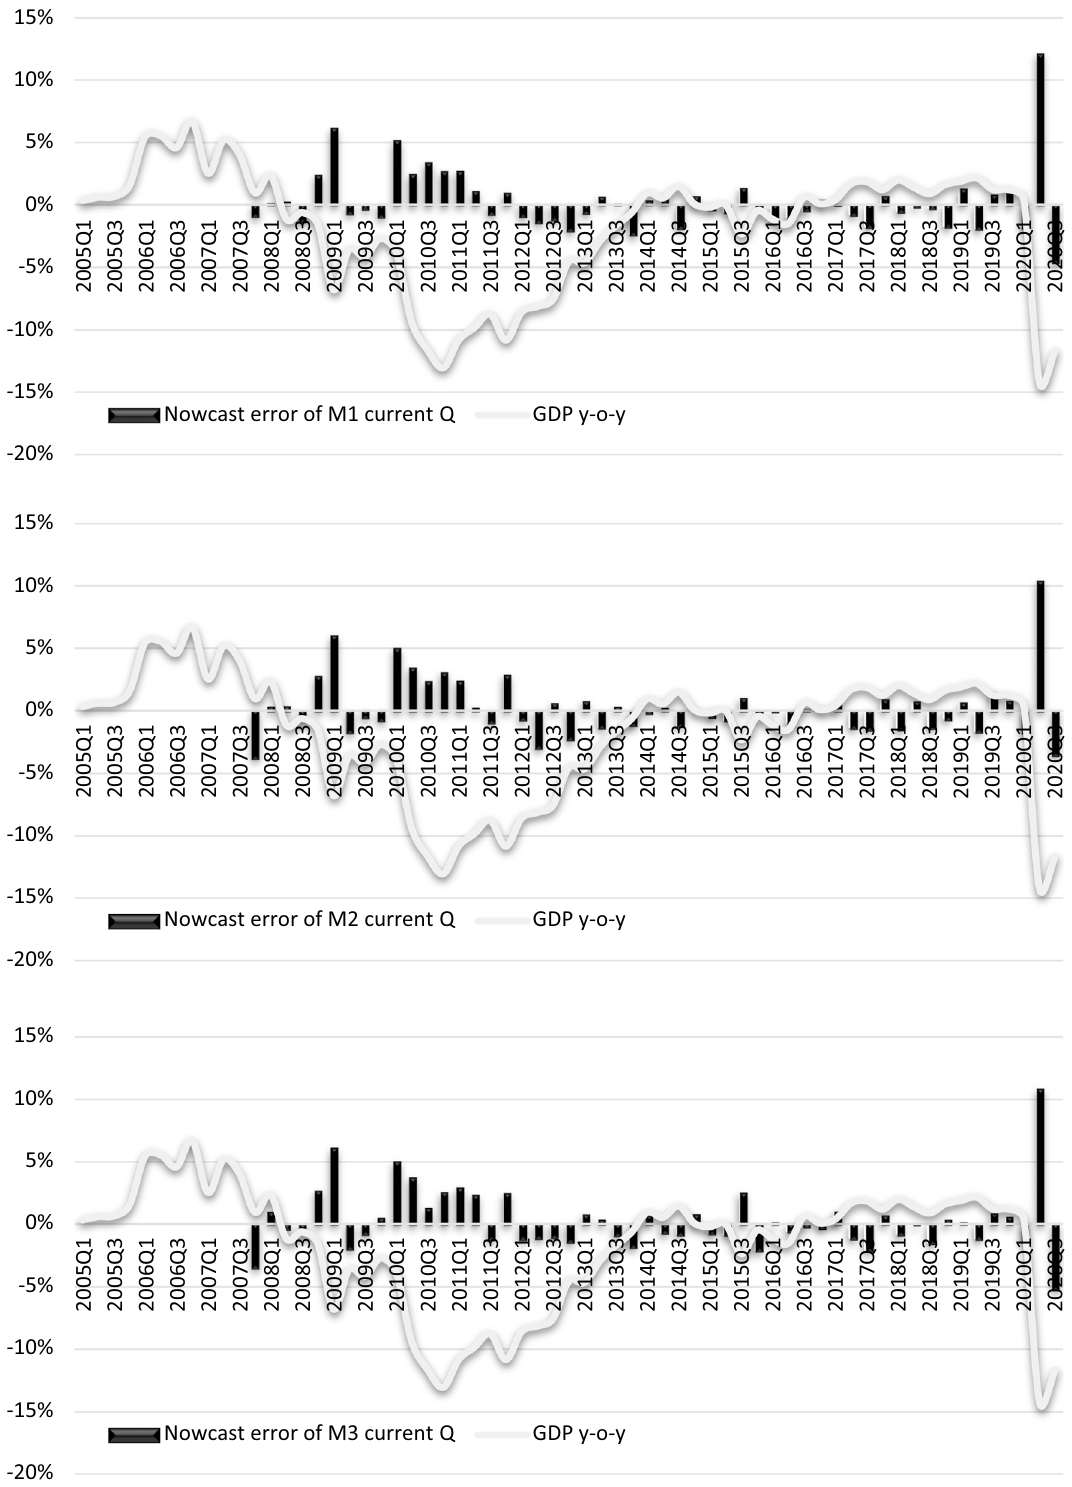
Y ( 0 ) q − Y ( 0 ) q / Y ( 0 ) q − 4 of the disaggregated Midas model with the nowcasting (cid:29) (cid:31) (cid:30)